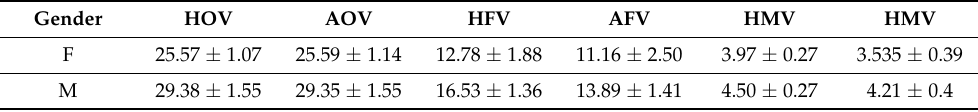
Table 5. Average and standard